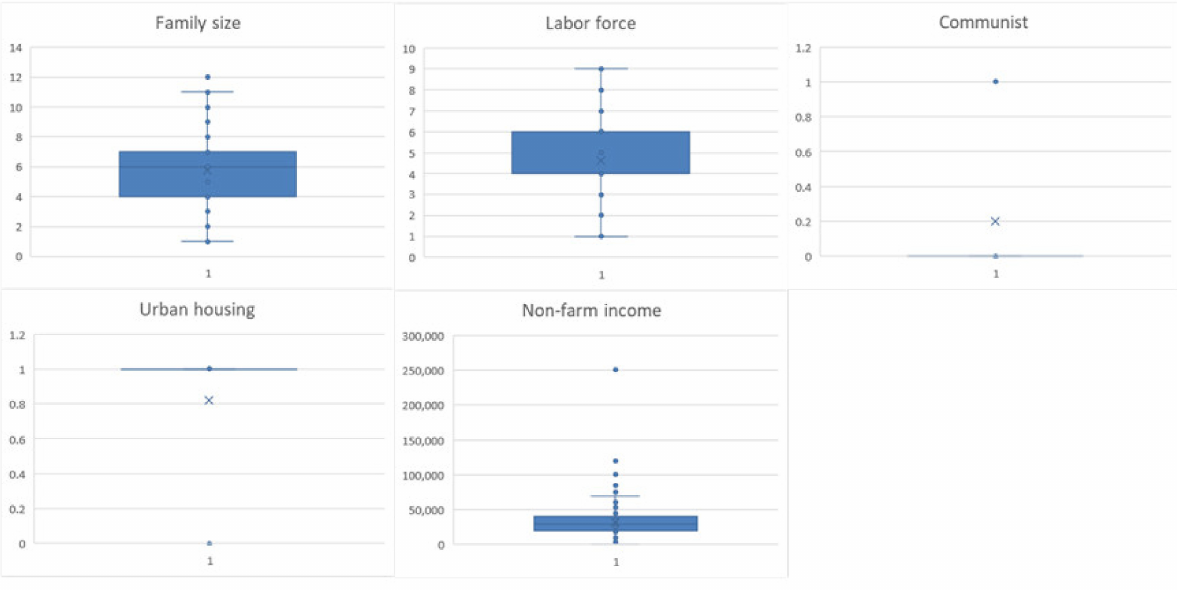
Figure 4. Boxplots of family characteristics descriptive